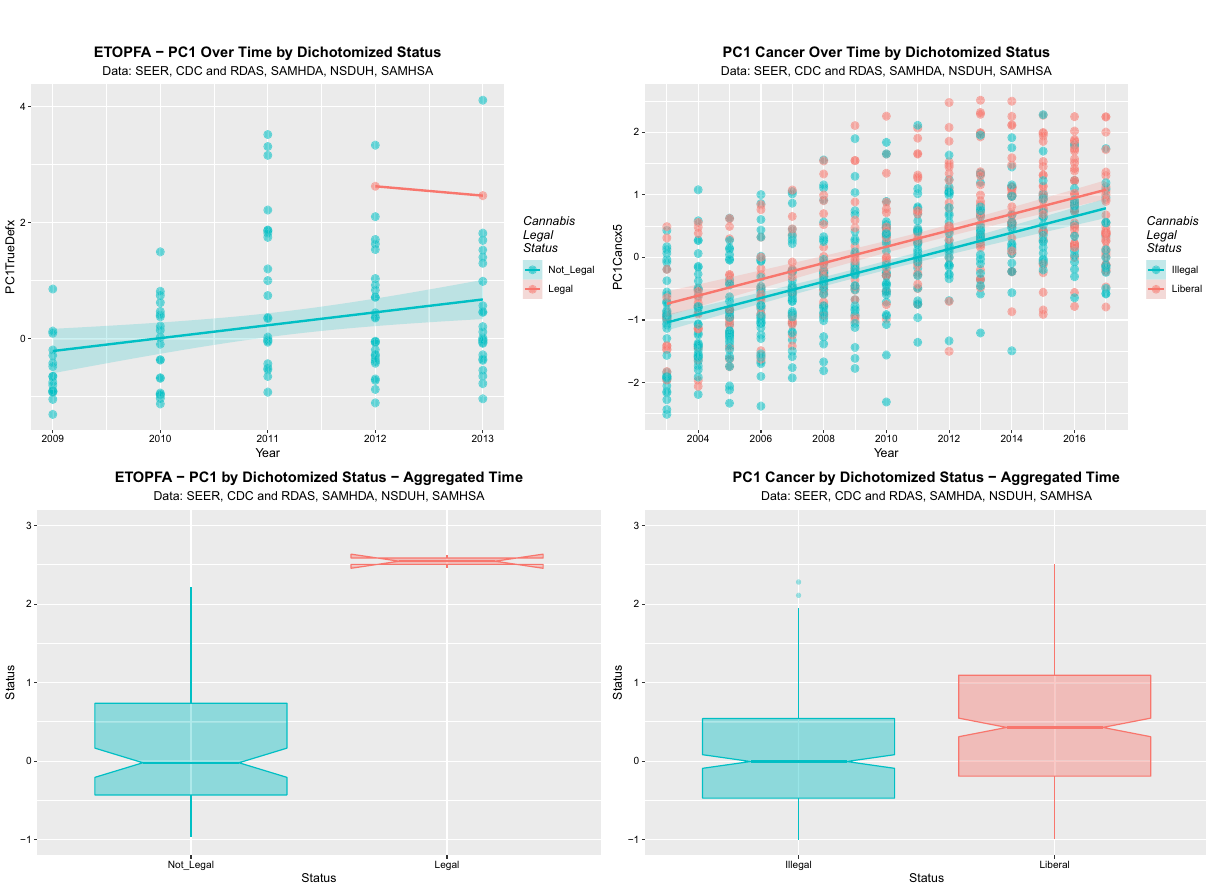
Figure 9. Effect of dichotomized cannabis legal status on PC1 for ETOPFA-corrected and cancer data. ( A ) Scatterplot over time for PC1 for ETOPFA-corrected anomalies for legal status dichotomized as legal cannabis states v not legal cannabis states. ( B ) Scatterplot over time for PC1 for cancer incidence dichotomized by legal status as illegal states v. liberal states. ( C ) Boxplot for PC1 for ETOPFA-adjusted congenital anomalies time- aggregated data by legal status dichotomized as in ( A ). ( D ) Boxplot for PC1 for selected cancer incidence of dichotomized legal status over aggregated time dichotomized as in ( B ). (Created in R-Studio version 1.3.1093 using ggplot2 version